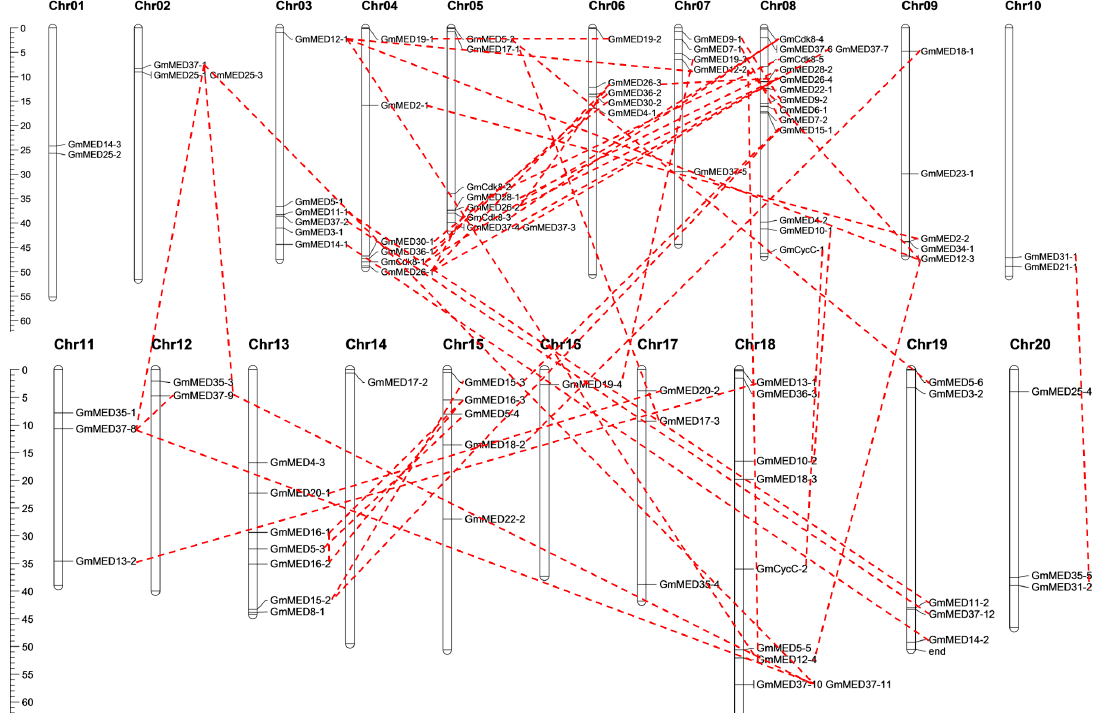
Figure 1. Chromosomal location and duplications of soybean mediator complex subunits. The chromosome number is indicated above each bar and the scale on the left is in MegaBases (Mb). The chromosome size is indicated by its relative length using the information from Phytozome and SoyBase. Each pair of segmental duplication is indicated by the dashed lines.